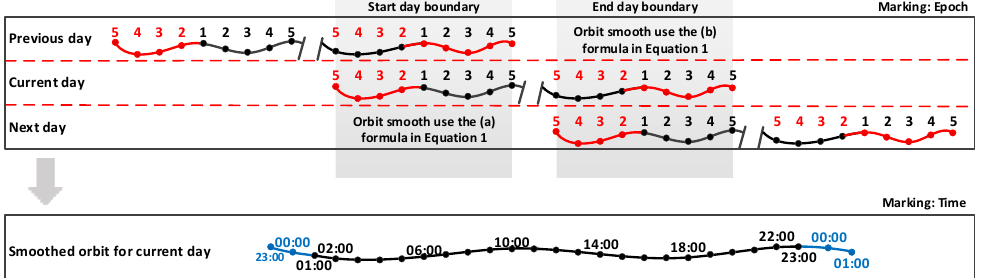
Figure 1. Illustration of orbit calibration for adjacent days. The black, red, blue segments denote the initial orbit, the forecasted orbit, and the calibrated orbit, respectively.